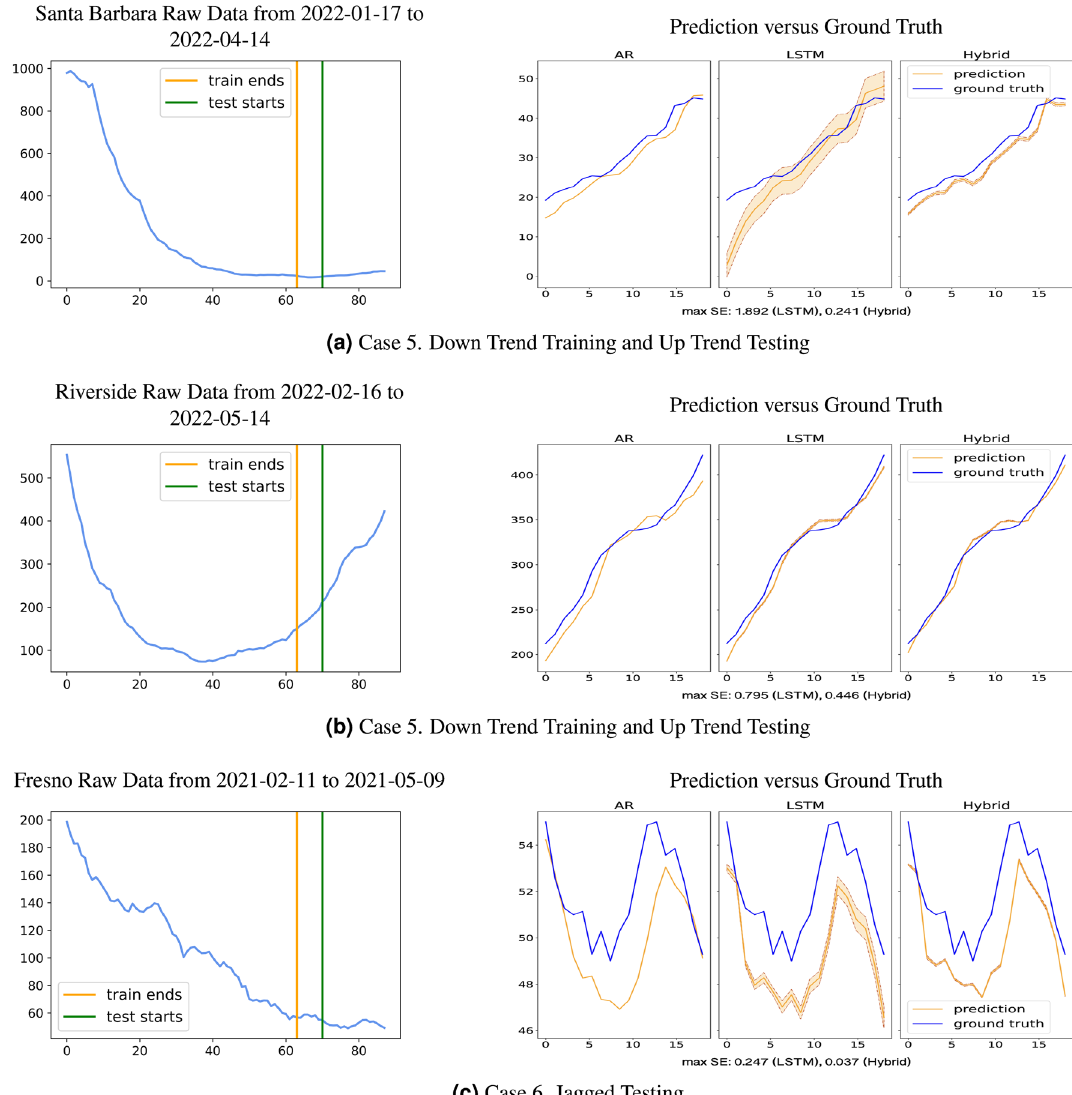
Figure 4. The left panels show the training and testing data. The right panels show the ground truth versus forecasts of the AR, LSTM, and hybrid model, respectively. We display the average prediction (solid line) with 2 times standard error (shaded region). The standard error across 100 runs are reported for LSTM and hybrid. The hybrid model is more stable than the LSTM.